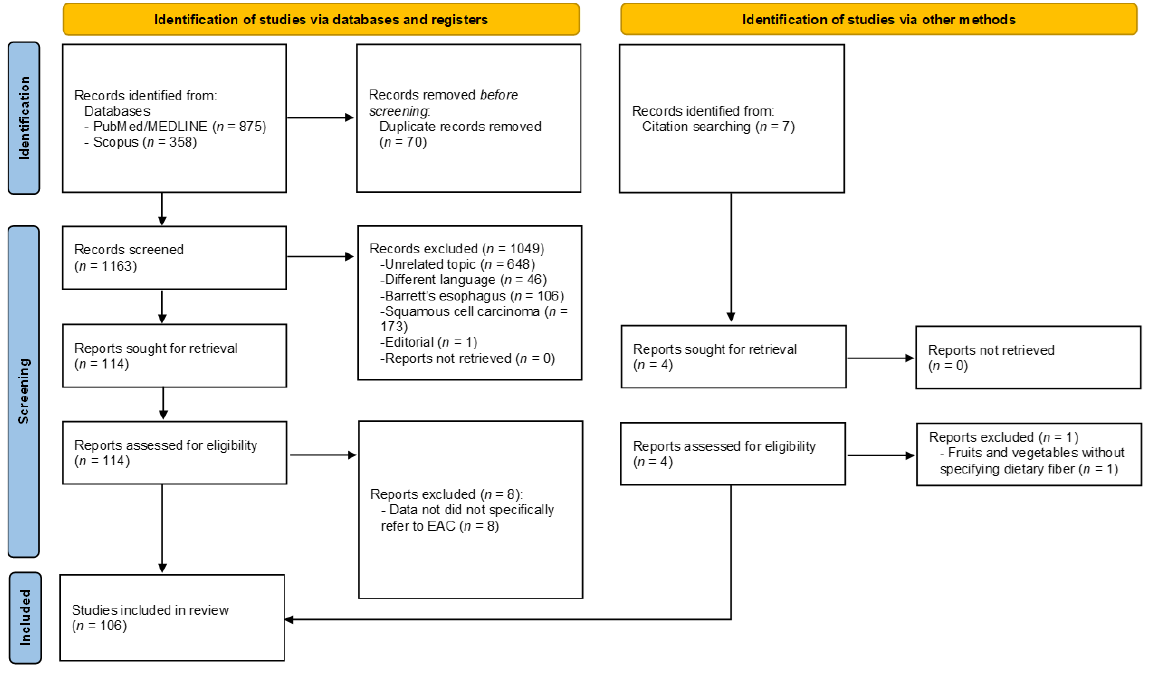
Figure 1. Flowchart depicting the studies’ selection processes (PRISMA flow diagram). Table 2. All included studies (cohort, cross-sectional, and case-control), stratified by risk factors, direction of the association (beneficial, detrimental, or no effect), and quality evaluation. Numbers in square bracket refer to the number of